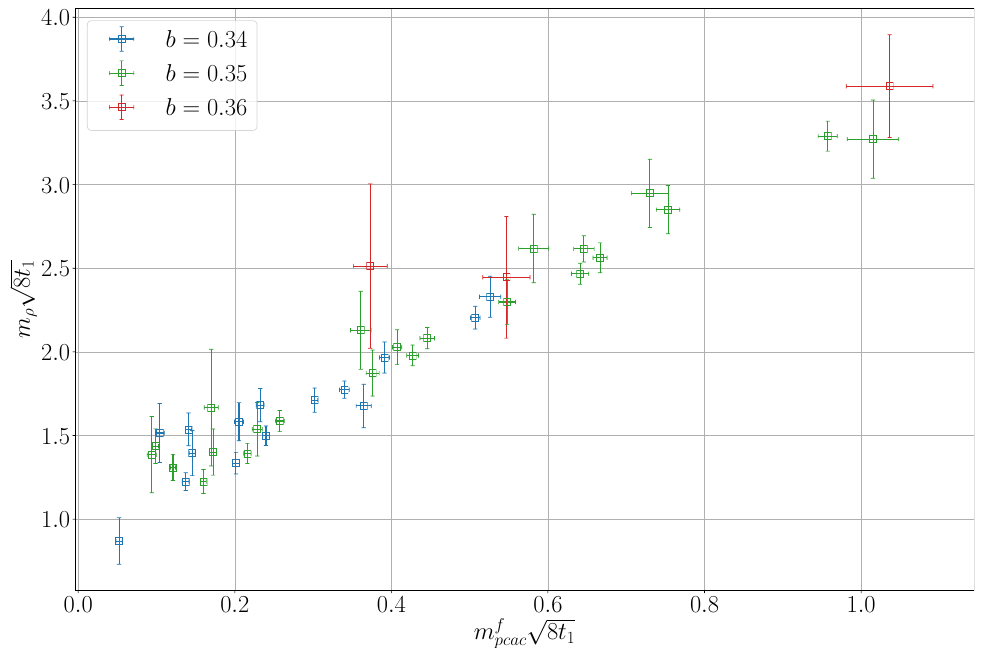
Figure 12. Dependence of m